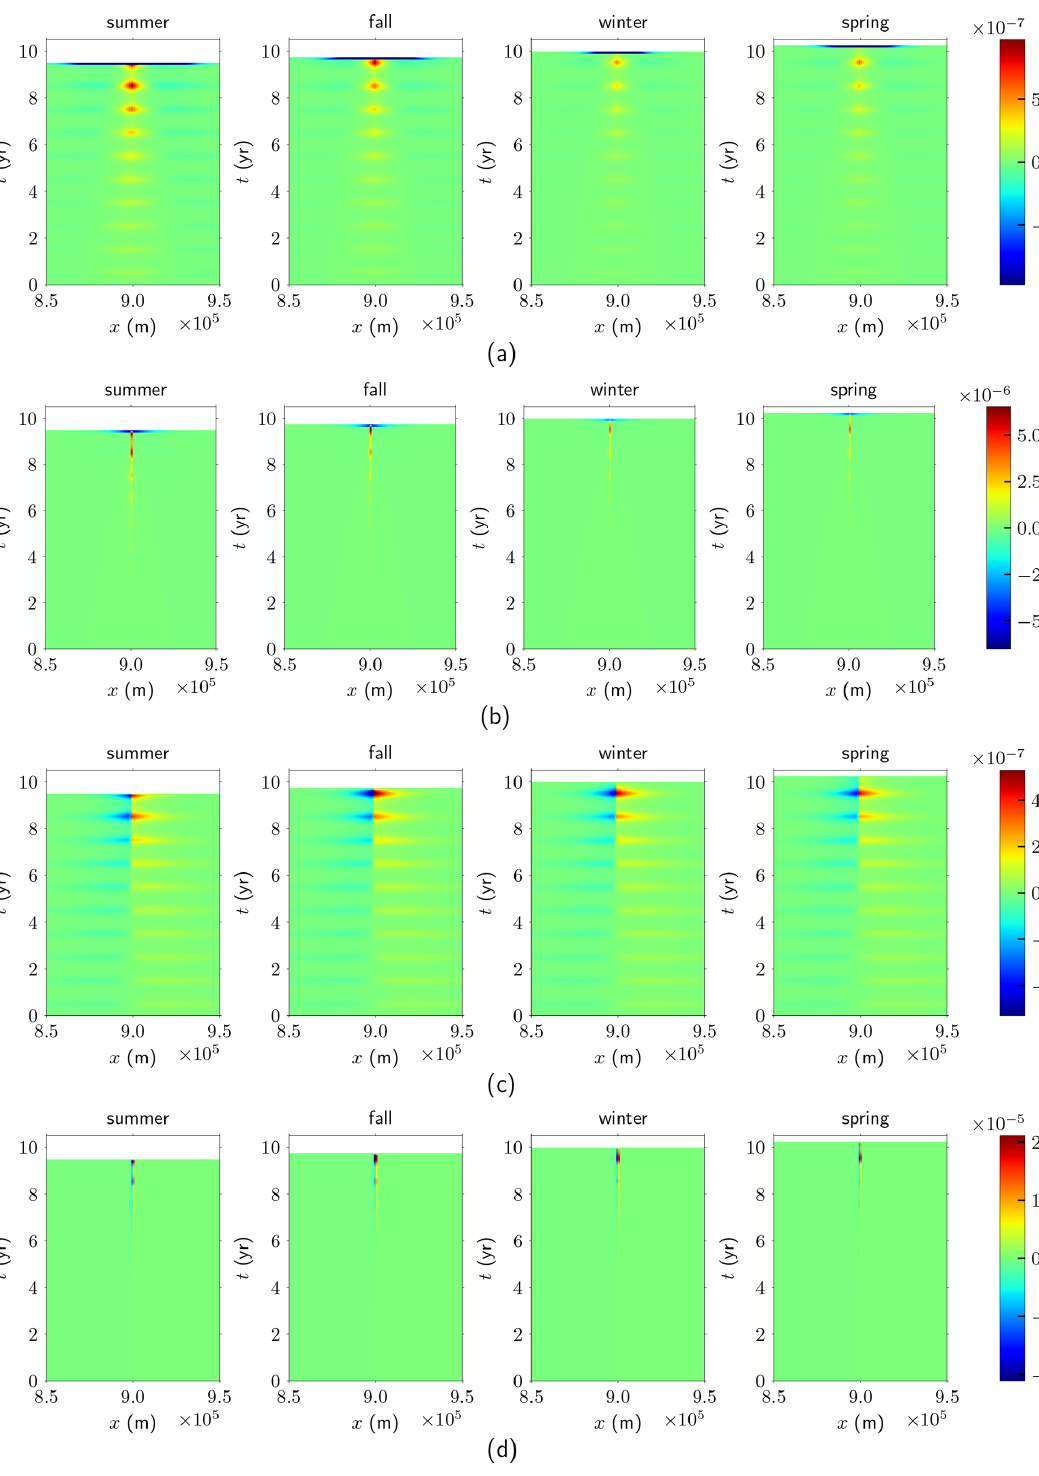
Figure 8. The adjoint weights for the observations at x ∗ = 9 × 10 5 m of the four seasons. (a) w C for the observation of u . (b) w b for the observation of u . (c) w C for the observation of h . (d) w b for the observation of h